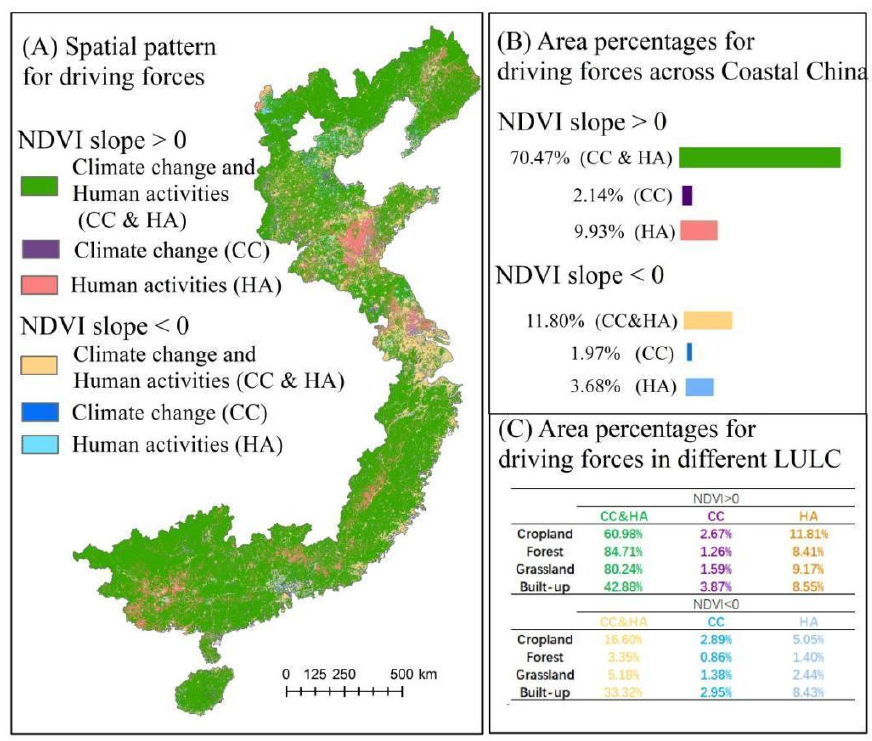
Figure 3. Driving forces of vegetation dynamics in coastal China during 2000–2019. CC and HA represent climatic change and human activities, respectively. The color in ( C ) is same as that in ( A ) and ( B